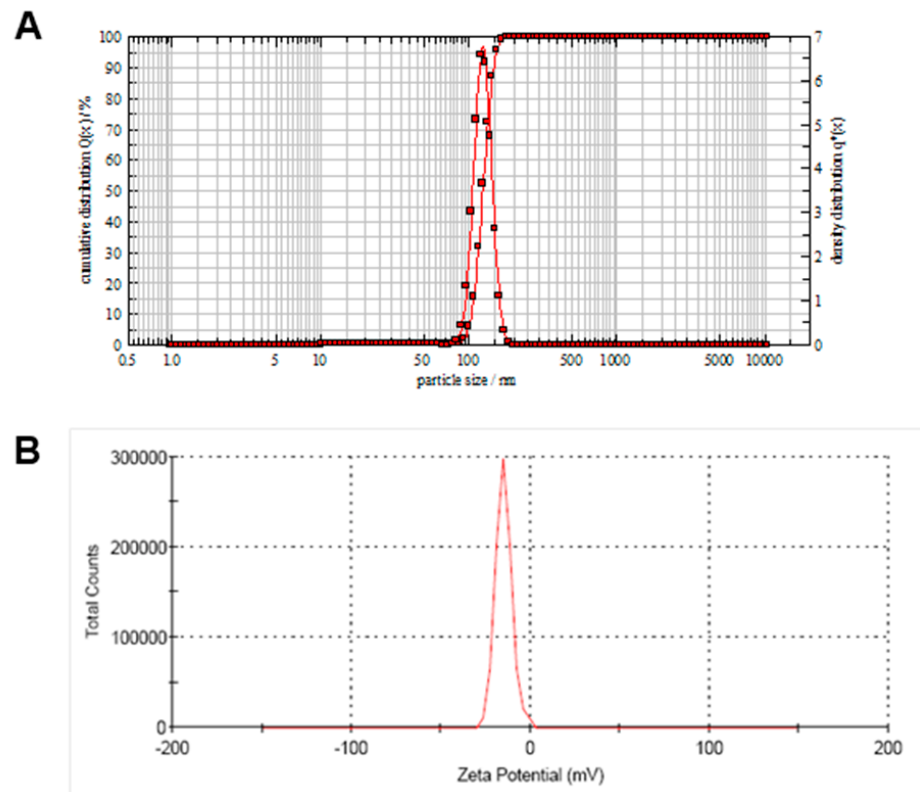
Figure 2. Characterization of nanoemulsion of chrysin obtained after dilution of nanoemulsifying preconcentrate with water. ( A ) Particle size measured using photon cross-correlation spectroscopy and ( B ) Zeta potential.